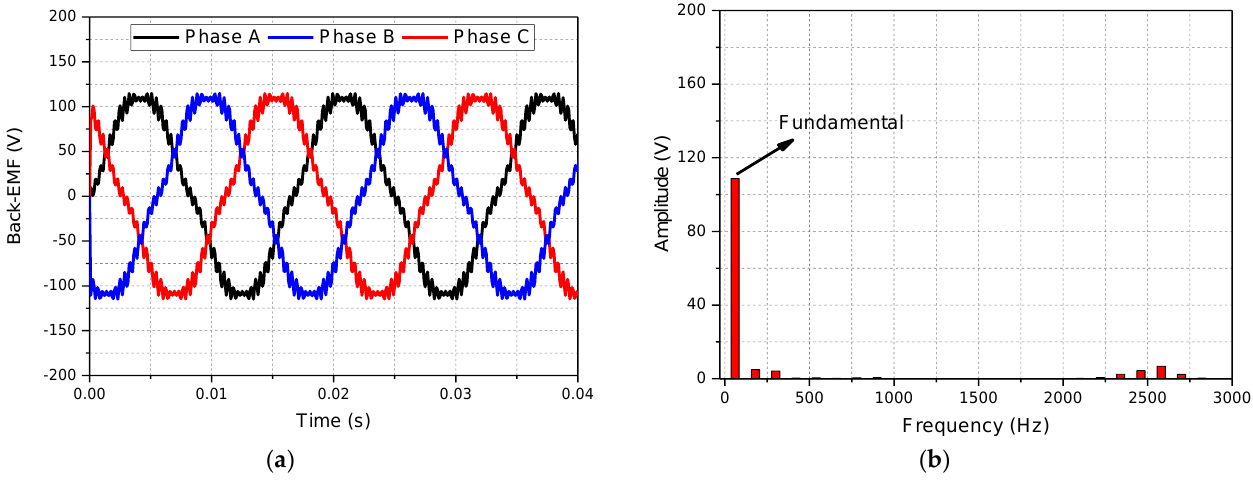
Figure 13. Cogging torque.